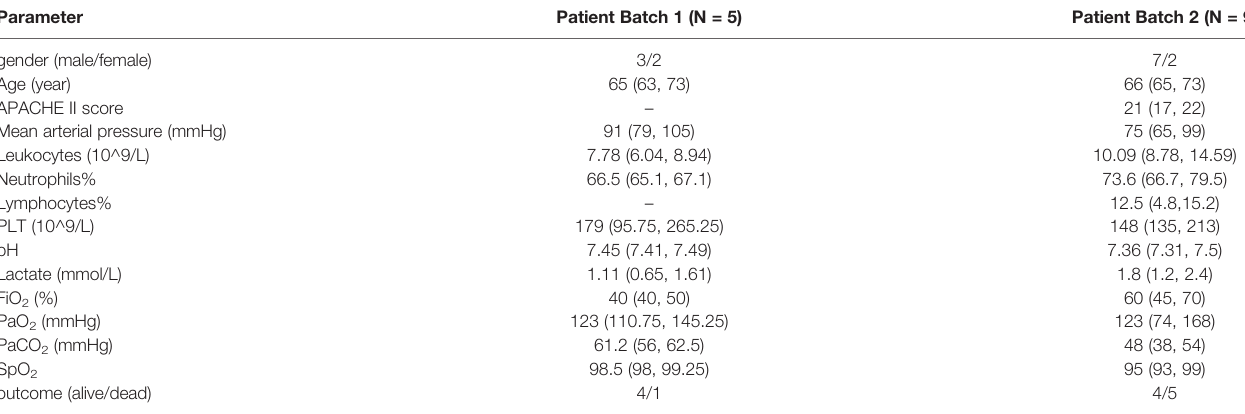
TABLE 1 | Demographic and clinical characteristics of the 14 enrolled